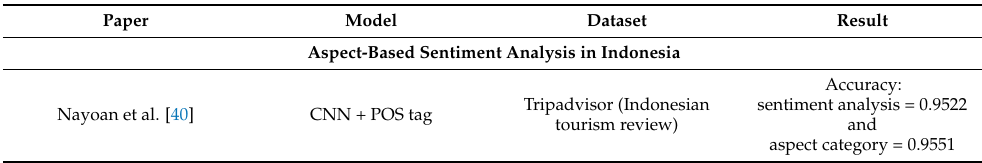
Table 1. The summary of related